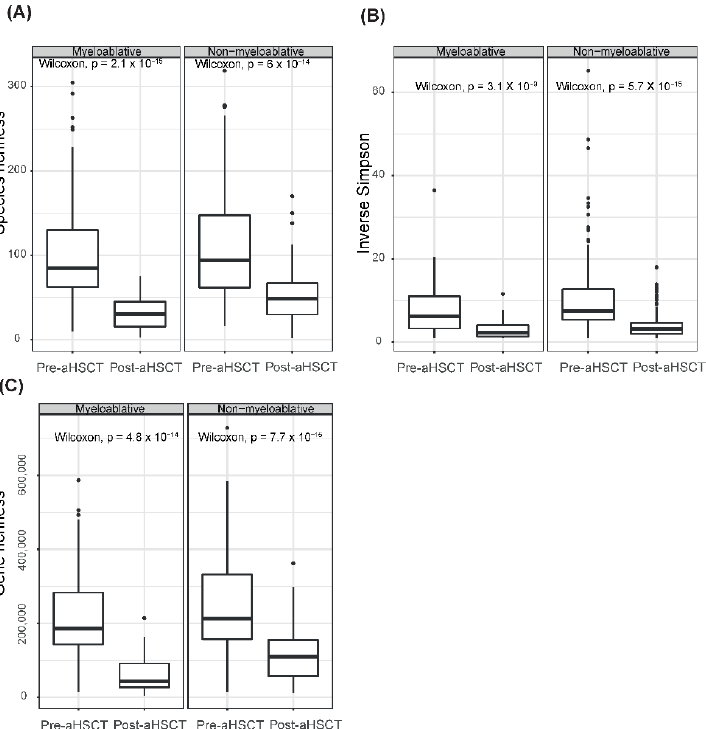
Figure 4. Gut microbiome diversity and associations with timepoints. Boxplots of gut microbial diversity (( A ) species richness, ( B ) alpha diversity and ( C ) gene richness) in pre-aHSCT vs. post-aHSCT samples for the myeloablative and non-myeloablative groups. Wilcoxon tests were performed per diversity measure and conditioning regimen.